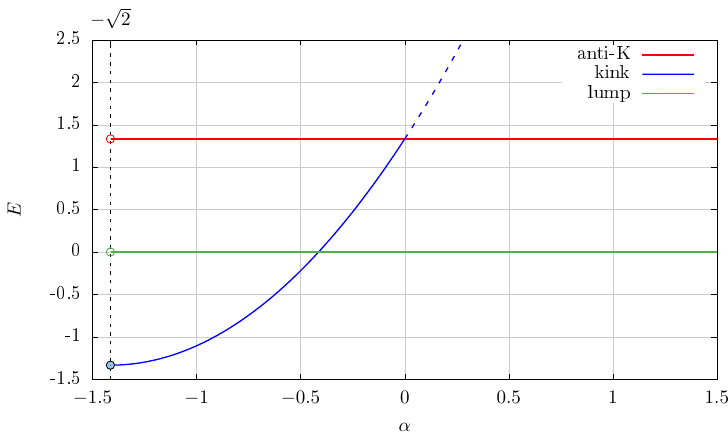
Figure 10 . Energies of the kink-impurity, antikink-impurity and topologically trivial lump solu- tions as functions of (cid:11)